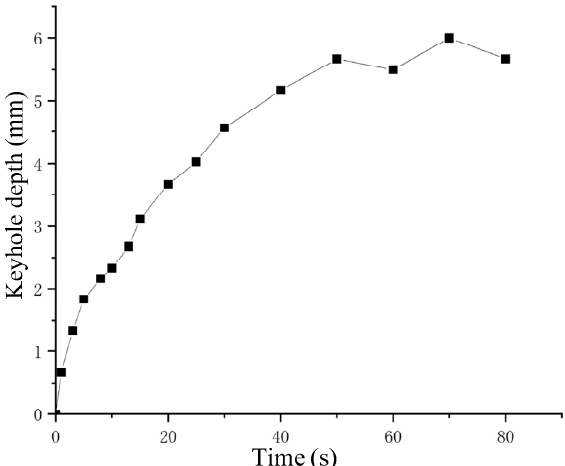
Figure 15. The variation of keyhole depth with time.